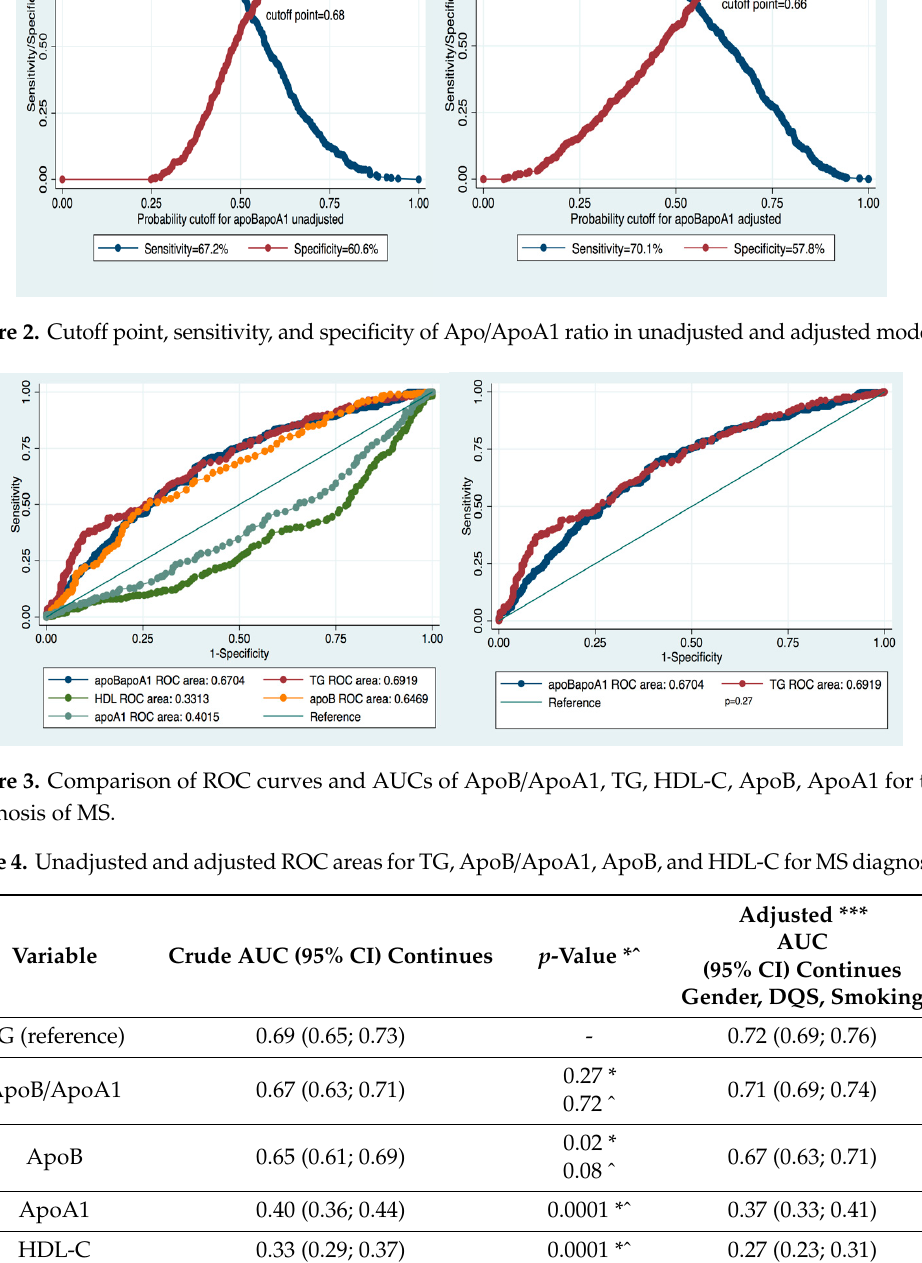
Figure 1. Receiver operating characteristic (ROC) curves and area under the curve (AUC) for the ApoB/ApoA1 ratio in unadjusted and adjusted regression logistic models for the association between MS and ApoB/ApoA1 ratio.